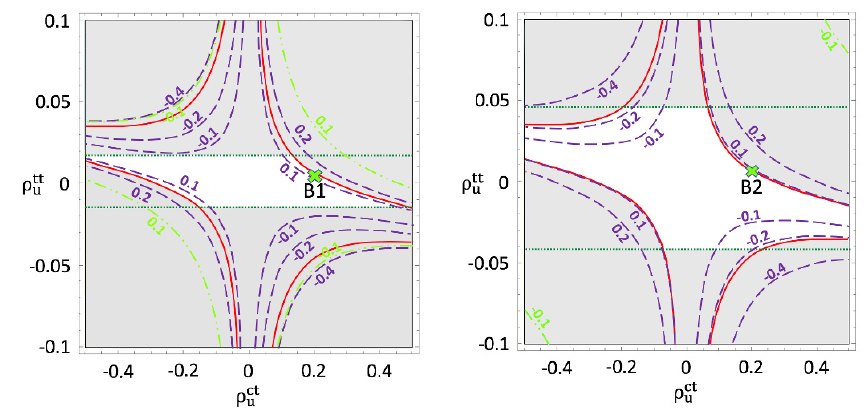
Figure 6 . (cid:26) tt vs. (cid:26) ct in the case (B) with (cid:26) (cid:28)(cid:22) = 1(left) ; 0 : 1(right) and ( m A ; m H ; m H u u e (200 GeV ; 250 GeV ; 200 GeV). (cid:26) (cid:22)(cid:28) is (cid:12)xed at (cid:26) (cid:22)(cid:28) = (cid:0) 0 : 034 ; (cid:0) 0 : 34 that correspond to (cid:14)(cid:11) (cid:22) = e e (2 : 61) (cid:2) 10 (cid:0) 9 . The gray region is excluded by the B s (cid:0) B s mixing (red lines) and (cid:28) ! (cid:22)(cid:13) process (dotted green lines). The dashed green lines and dashed purple lines denote the predictions of (cid:1) C 9 and (cid:1) C 10 for the each case. The size of the deviation is shown on the each